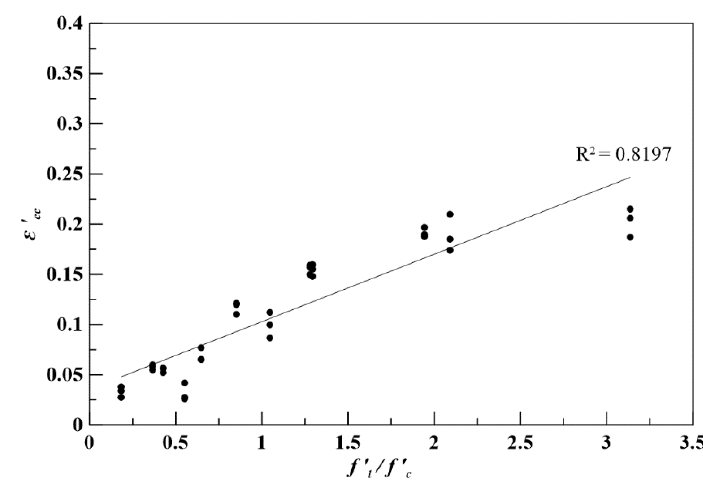
ε ' ' Figure 8. The ε (cid:48) cc and( f (cid:48) / f c ) relationships of the constitutive model and experimental Figure 8. The and( cl ff / ) relationships of the constitutive model and experimental l cc consequences.